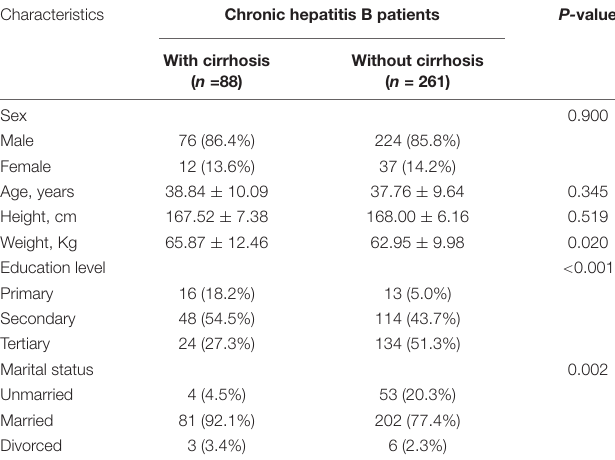
TABLE 1 | Demographics data in patents enrolled. TABLE 2 | Factors of health-related quality of life in cirrhosis